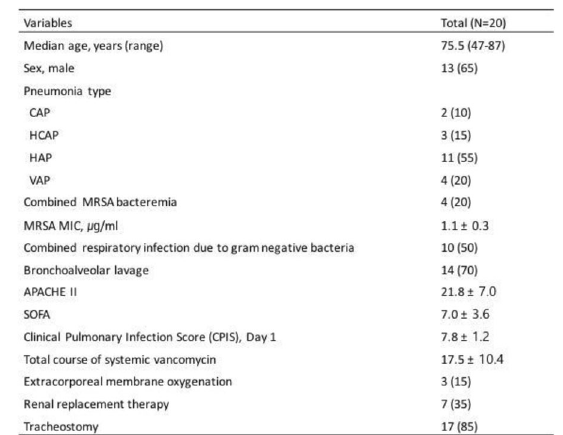
Table 1 (abstract 0018). Baseline characteristics